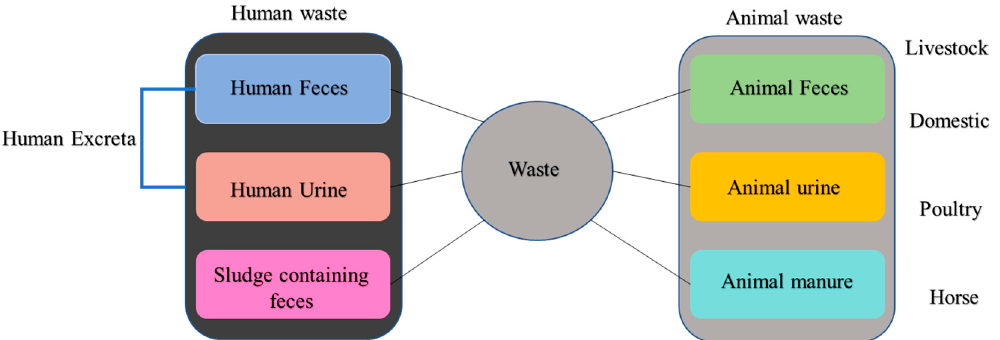
Figure 1. Classification of human and animal waste considered in this study. Note that, while there are several waste classifications, the one presented herein is based on the authors’ experience and the scope of the present study.